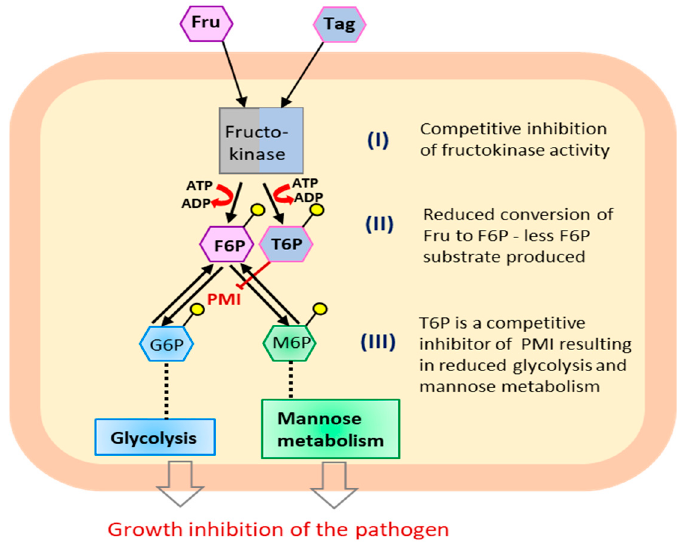
Figure 4. Proposed mechanism involved in fungicide effect of D-tagatose (Tag) according to Mochizuki et al. [128]. Three steps of Tag chain-inhibitory effects on multiple targets in Hyaloperonospora arabidopsidis , causal agent of Arabidopsis downy mildew: ( I ) through competitive inhibition of fructokinase activity, Tag inhibits the first step of mannose metabolism-the phosphorylation of D-fructose (Fru) to D-fructose 6-phosphate (F6P) by fructokinase; ( II ) conversion of Tag to D-tagatose 6-phosphate (T6P) will reduce the conversion of Fru to F6P-less F6P means less substrate for glycolisis and mannose metabolism; ( III ) The produced T6P acts as a competitive inhibitor of phosphomannose isomerase (PMI) reducing glycolysis and mannose metabolism. Through steps I-III Tag inhibits the pathogen growth and disease development.